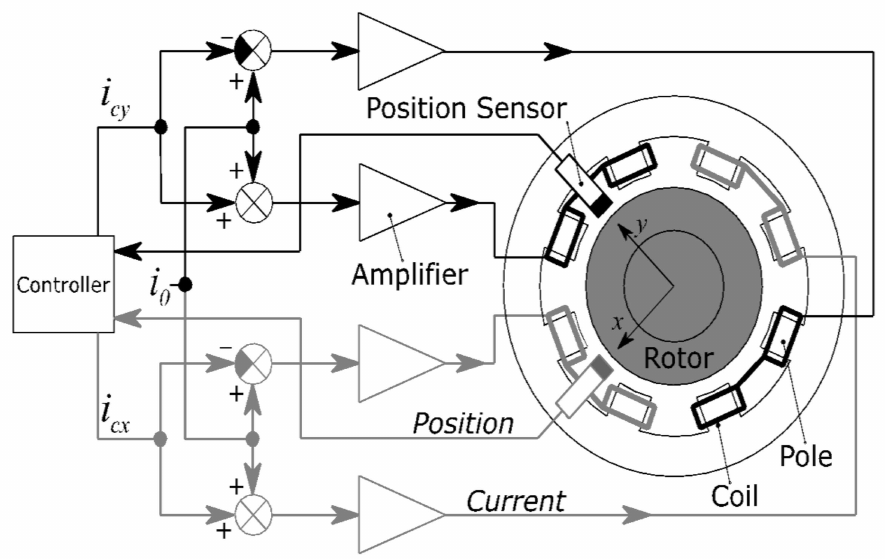
Figure 2. Radial magnetic bearing in differential drive